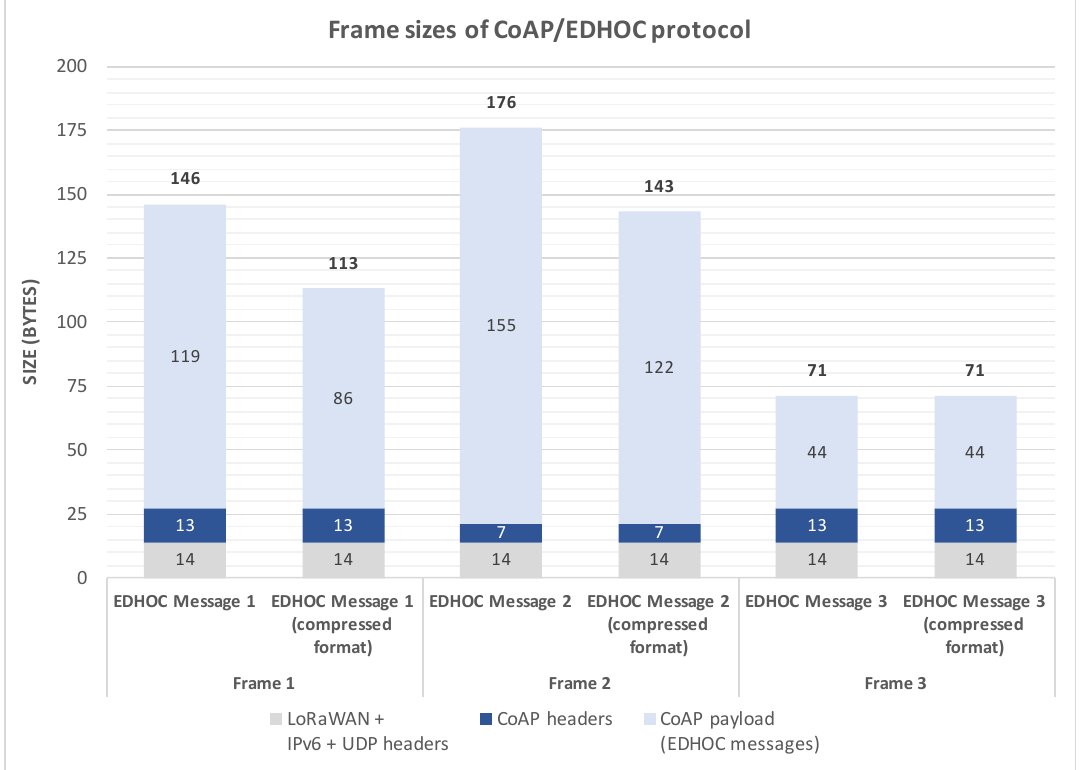
Figure 7. Sizes of MAC frames (LoRaWAN) including CoAP/EDHOC